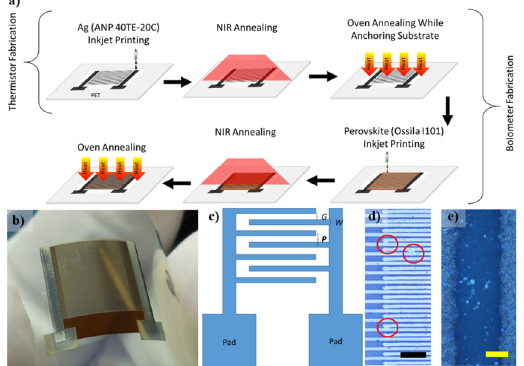
Fig. 1 Printed thermistor and bolometer devices. a Schematic of the printed device fabrication process. b Photograph of completed bolometer device. c Schematic of the silver interdigital electrode with the pitch ( P ), gap ( G ) and width ( W ) parameters. d Photograph of P = 40 µm silver interdigital electrodes showing electrical shorting pathways and the line bulging phenomenon (scale bar = 200 μ m). e Photograph of interdigital gap showing evidence of silver ink micro-splashing (scale bar = 10 μ m).